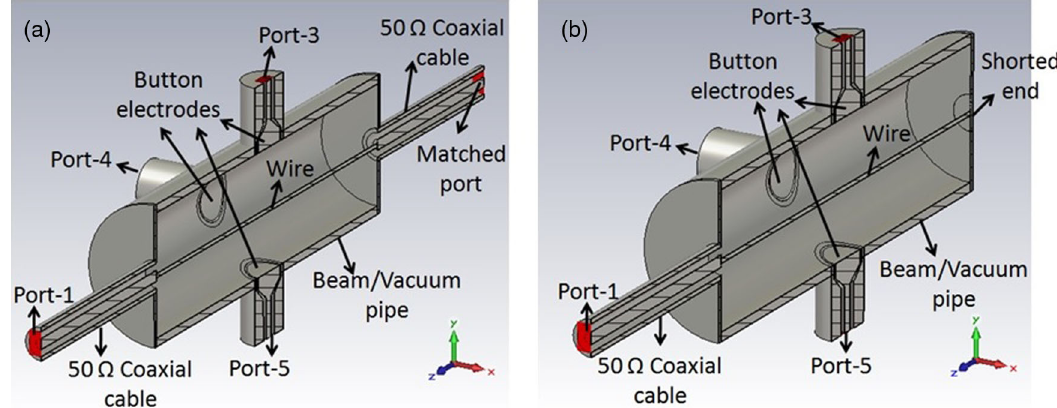
FIG. 7. CST model for the simulation of the modified coaxial wire method used for the calculation of transfer impedance of the test BPM. (a) 50 Ω downstream port and (b) shorted downstream port.